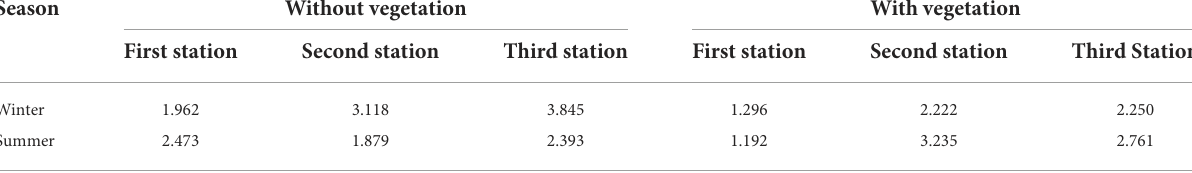
TABLE 7 Risk index (RI) value for heavy metals in Shadegan wetland soils (2019). Season Without vegetation